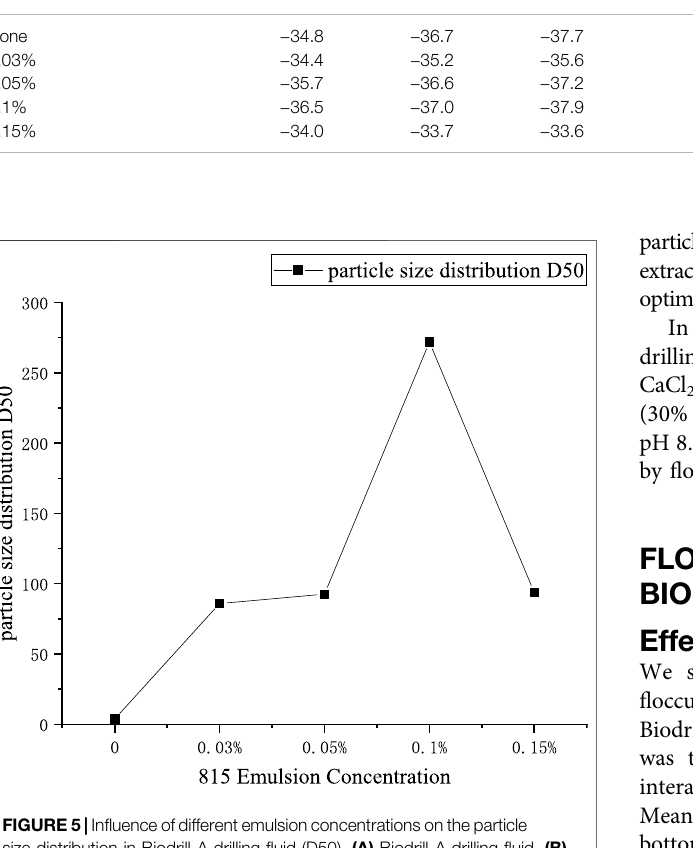
Frontiers in Energy Research |